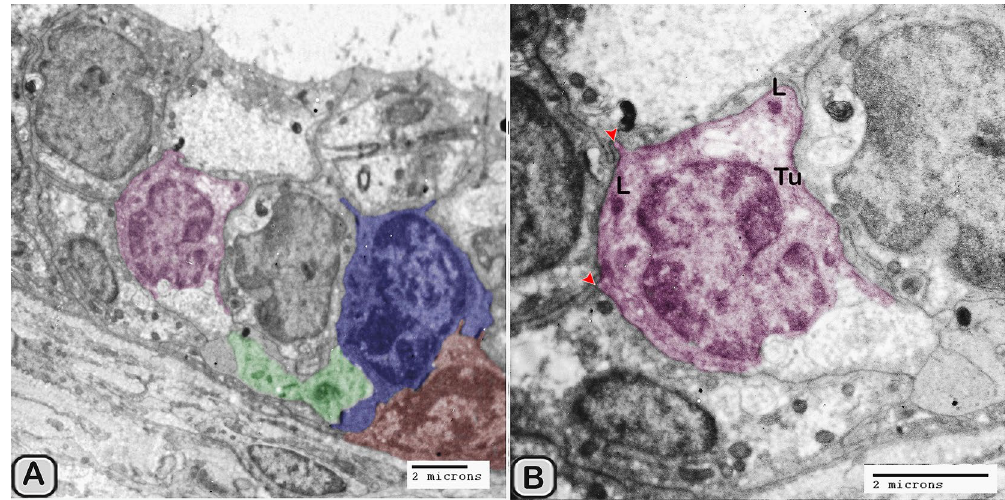
dendritic cells (blue), T-lymphocytes (brown) and nerve fibers (green). The nucleus was kidney shape and their cytoplasm contains lysosomes (L) and ill-developed endosomal tubular system